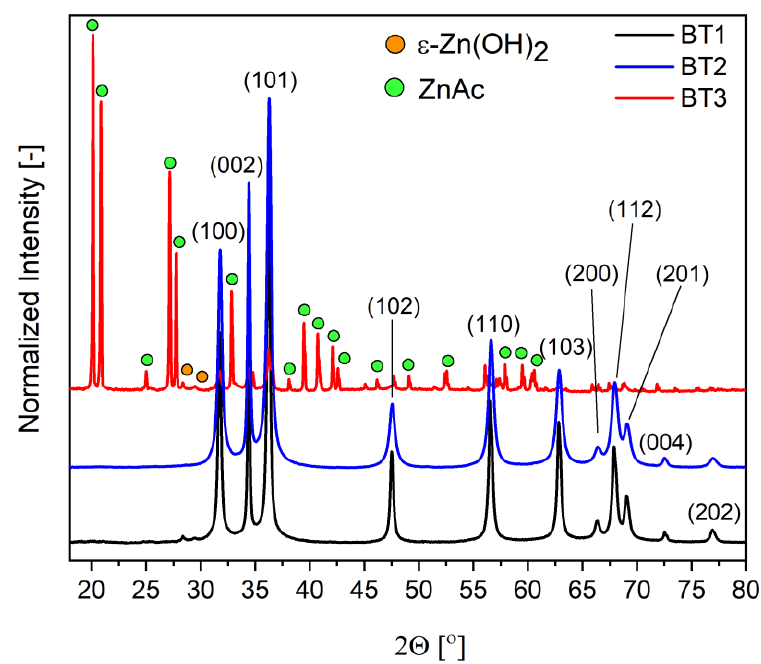
Figure 2. Diffractograms of the samples.